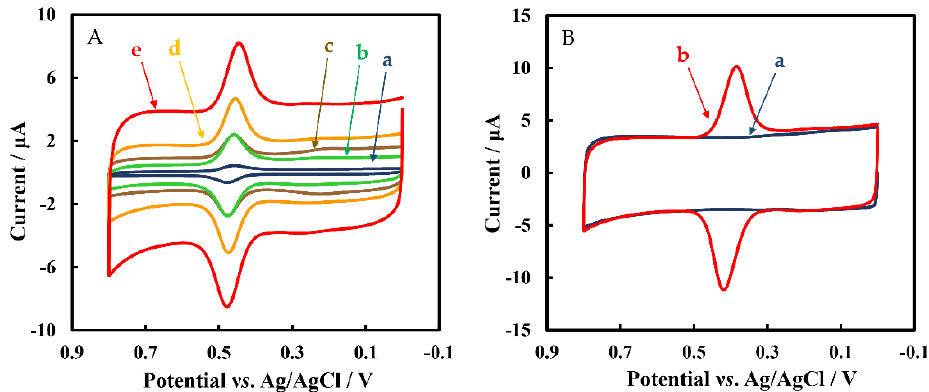
Figure 4. ( A ) CVs of different nanometer-material-modified GCEs in 50 mmol L − 1 pH 4 phosphate- buffered solution containing 5 µ mol L − 1 rutin: GCE (a), Chi/MWCNTs/GCE (b), Chi/MWCNTs- CTAB/GCE (c), Chi/HFs/MWCNTs-CTAB (d), Chi/Lac/HFs/MWCNTs-CTAB (e). ( B ) CVs of Chi/Lac/HFs/MWCNTs-CTAB in 50 mmol L − 1 pH 4 phosphate-buffered solution in the absence (a) and presence (b) of 5 µ mol L − 1